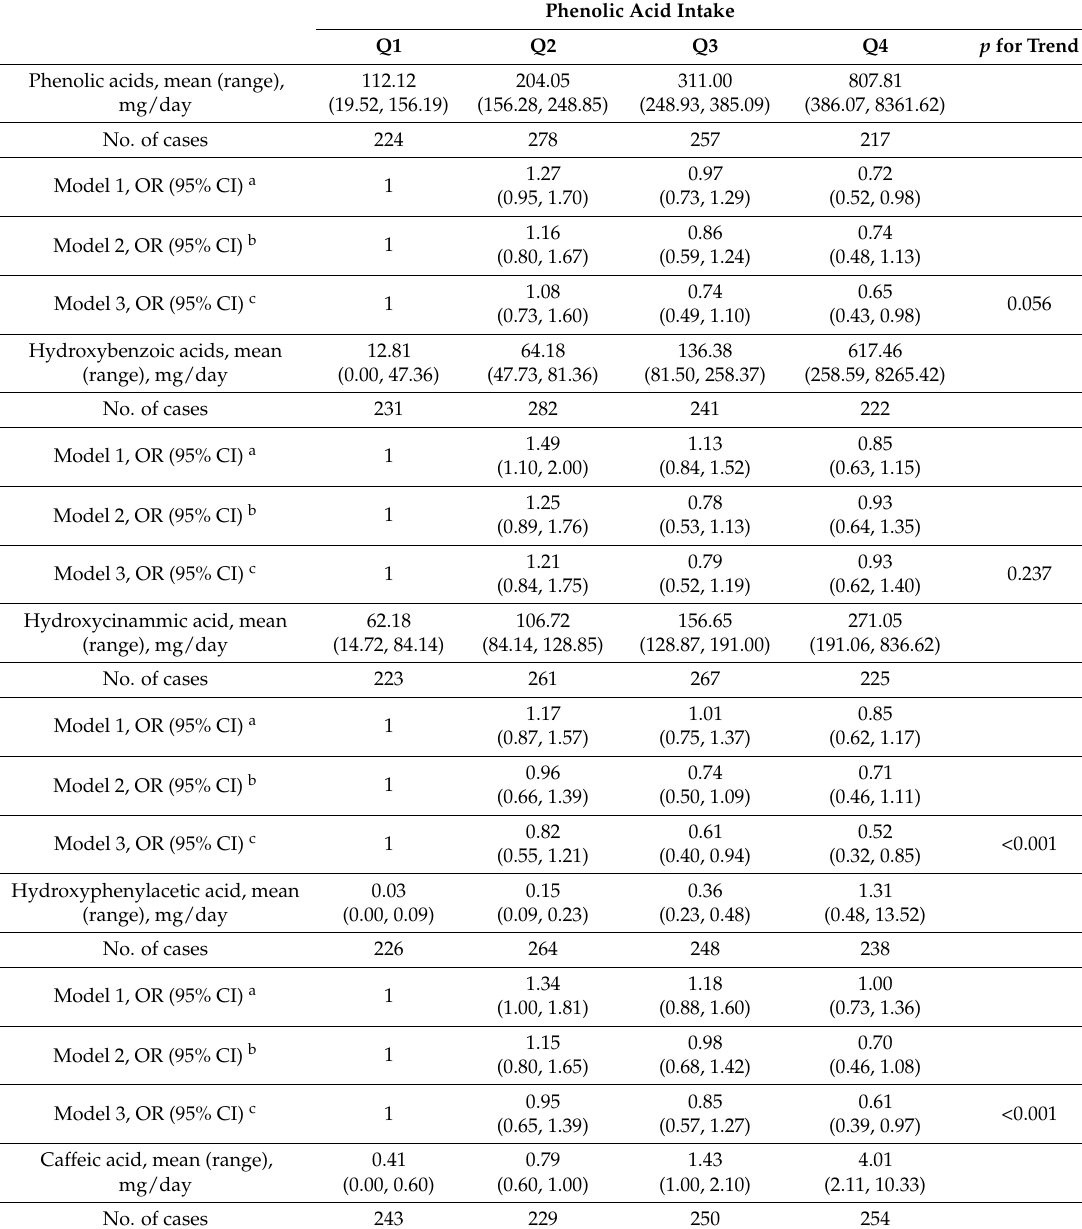
Table 2. Association between total, main classes, and individual phenolic acids and